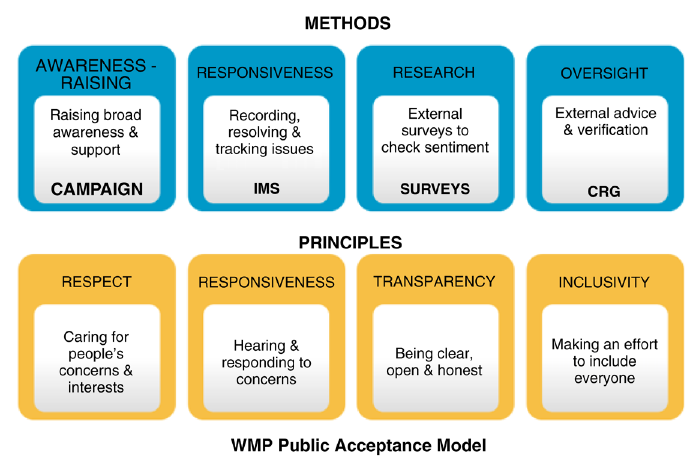
Figure 4. World Mosquito Program (WMP) Public Acceptance